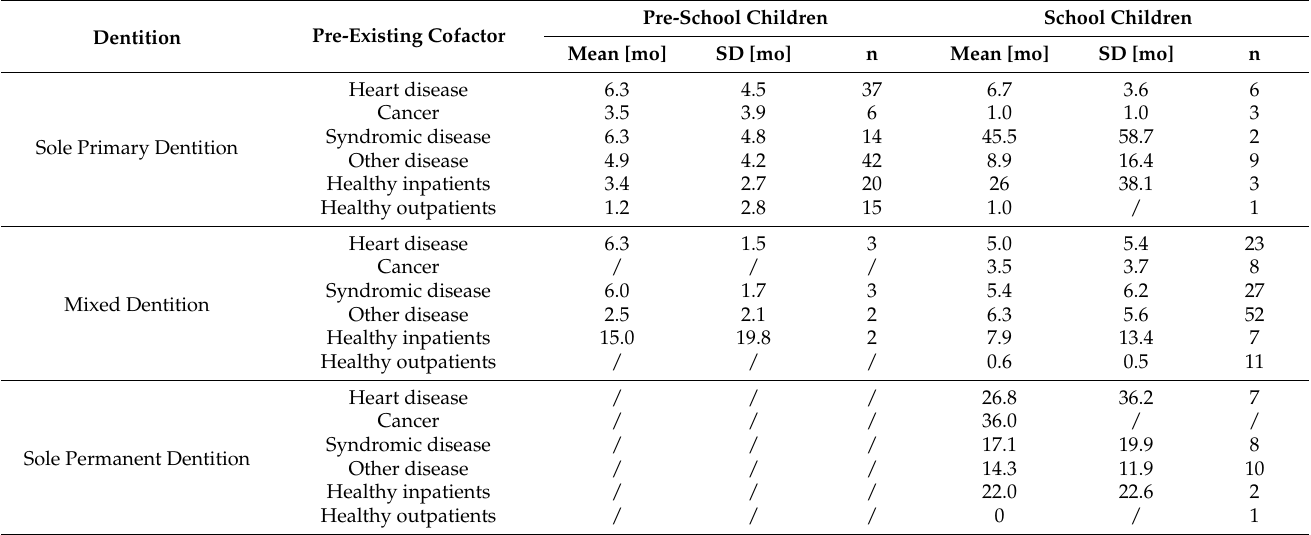
Table 2. Waiting time (in months) for dental treatment under general anesthesia according to group between impulses 1 and 2.